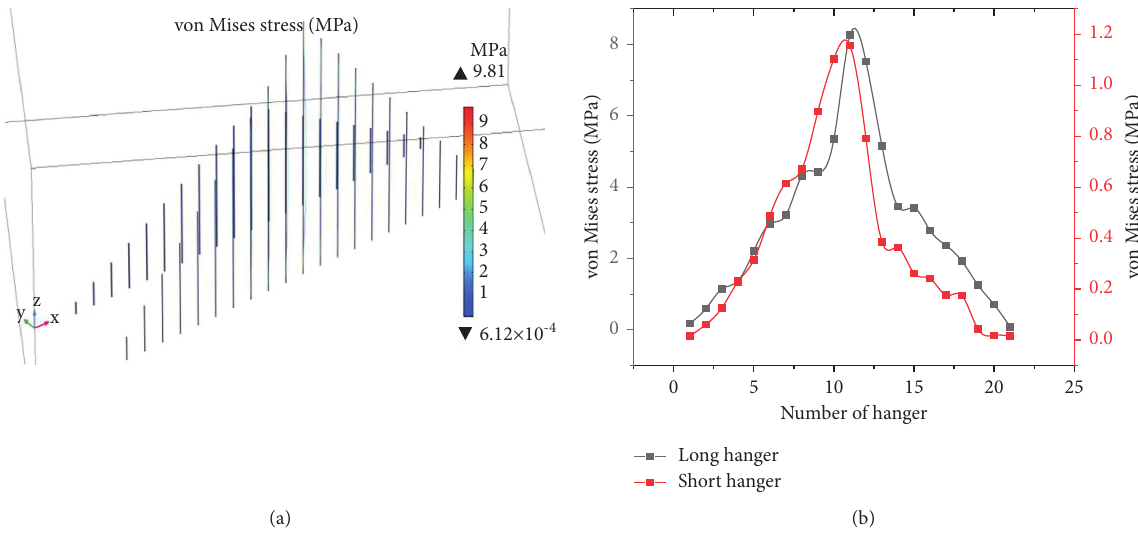
Figure 12: Stress distribution of hangers (wind direction � 210 ° /330 ° ).